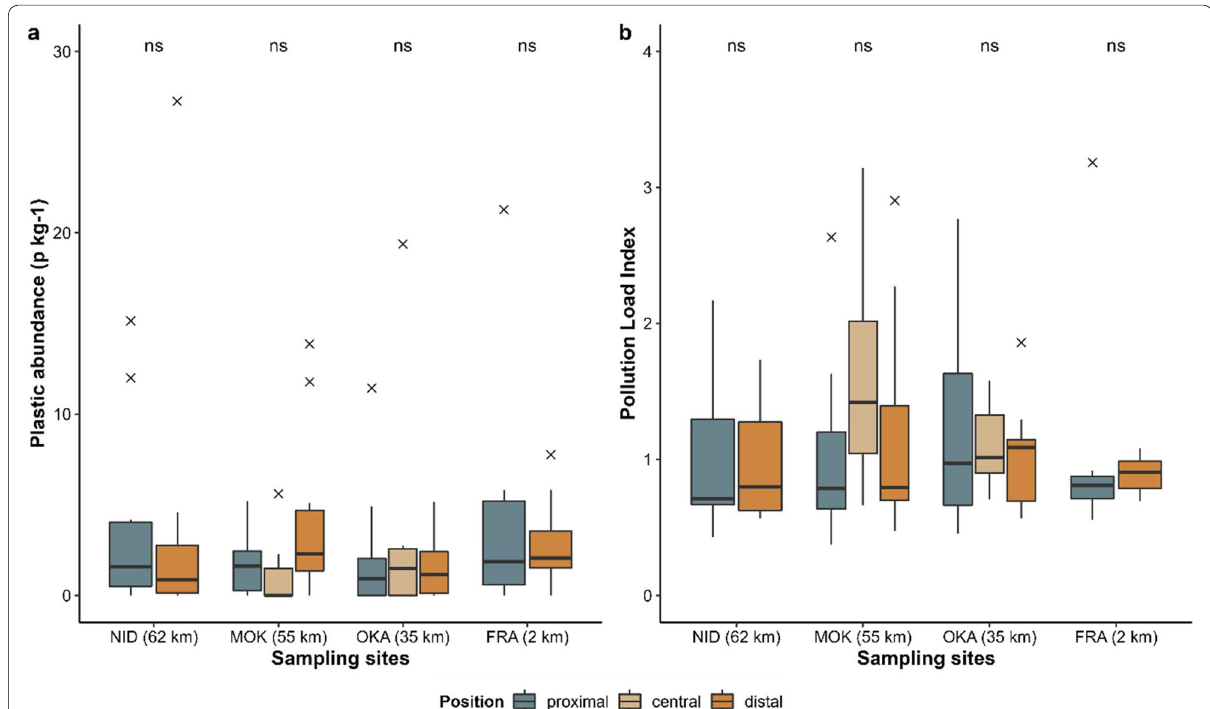
Fig. 3 Contaminants along the river course indicated with river length (km) and grouped according to floodplain positions (proximal, central, distal). a Plastic abundance (p kg − 1 ) at each sampling point ( n 10) and not significant (ns, p > 0.05) differences between sites; b PLI at each = sampling point ( n 10) and not significant (ns, p > 0.05) differences between sites =